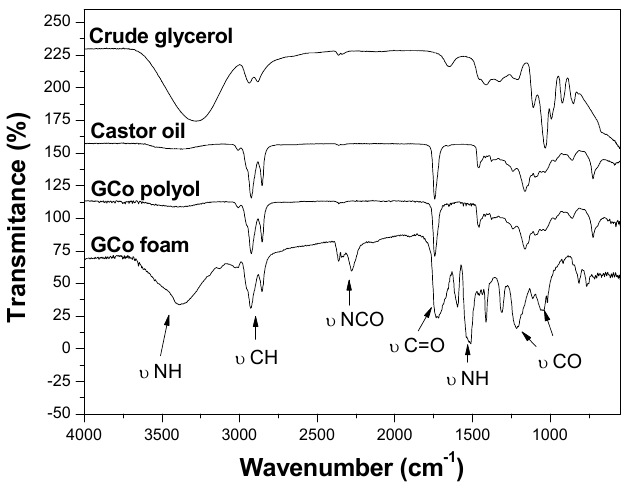
Figure 3. FTIR spectra for the raw materials, GCo polyol, and GCo foam (formulation II of Table